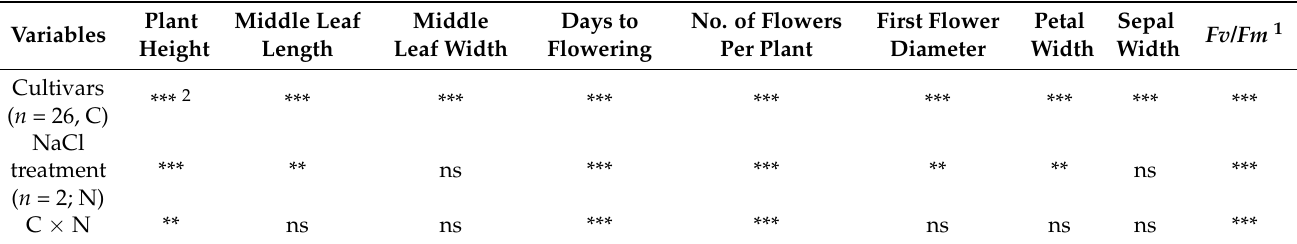
Table 1. Summary of the correlation among the flower characteristic and the growth traits in cut lily cultivars under the control and NaCl (8 dS m − 1 ) treatments based on ANOVA.